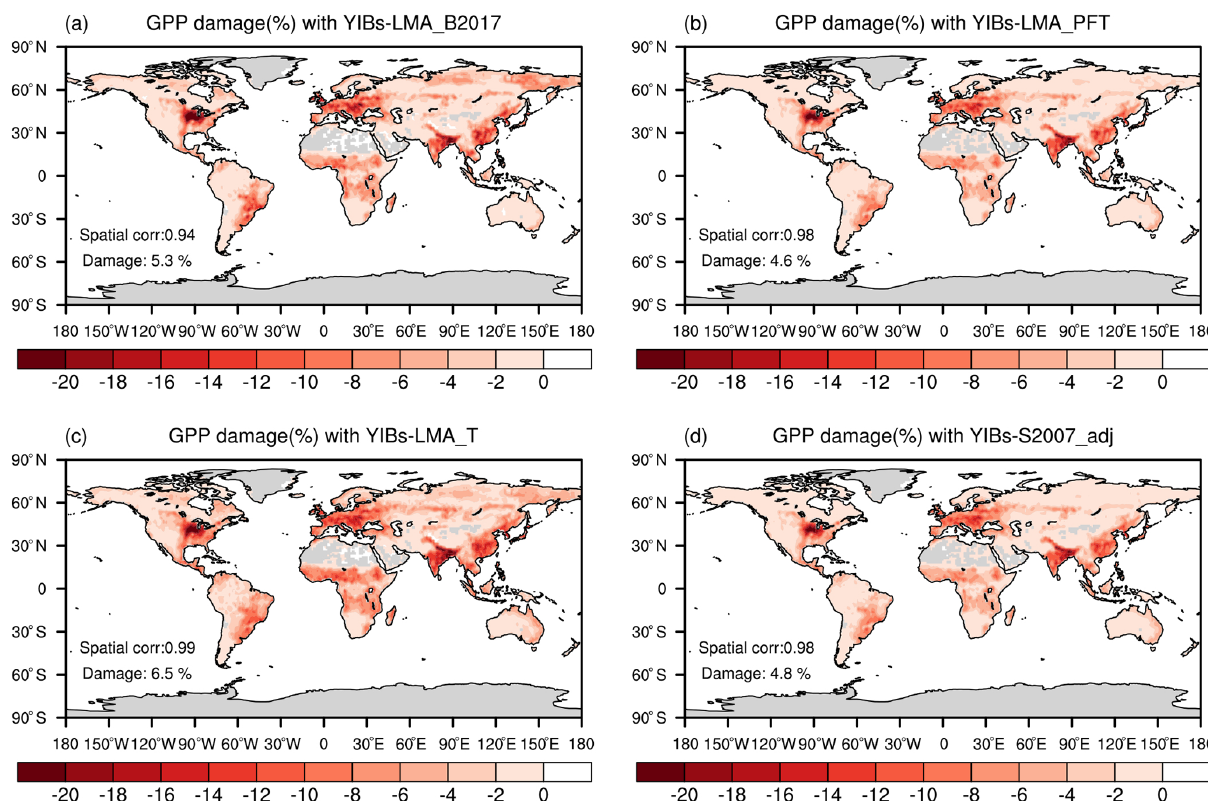
Figure 6. Global O 3 -induced GPP reductions simulated in four supporting experiments. All damage maps are based on optimal parameters shown in Table 1. The spatial correlation coefficients between YIBs-LMA and these supporting simulations are shown in each panel as well as the global average damage percentage of each map. Simulations are described in Table